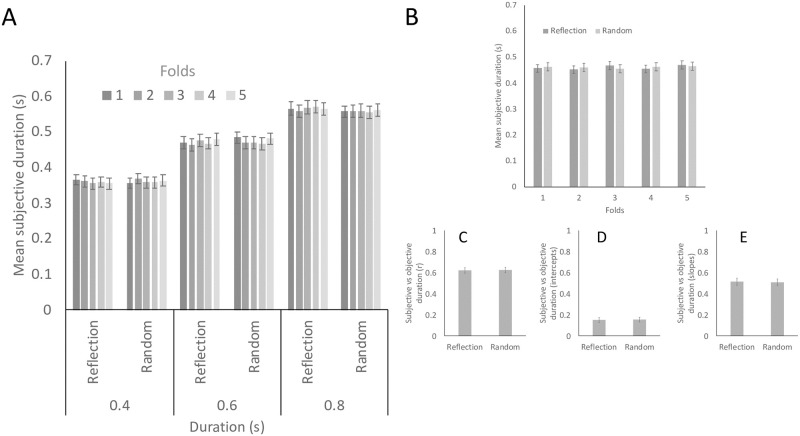
Results.A) Mean subjective duration in experimental trials. This is separated into reflection and random conditions with 1–5 folds. B) Mean subjective duration in filler trials in reflection and random conditions with 1–5 folds. C) Mean correlation of the relationship between objective and subjective duration in the filler trials. D) Intercepts of the relationship between objective and subjective duration in the filler trials. E) Slopes of the relationship between objective and subjective duration in the filler trials. Error bars = +/- 1 S.E.M.